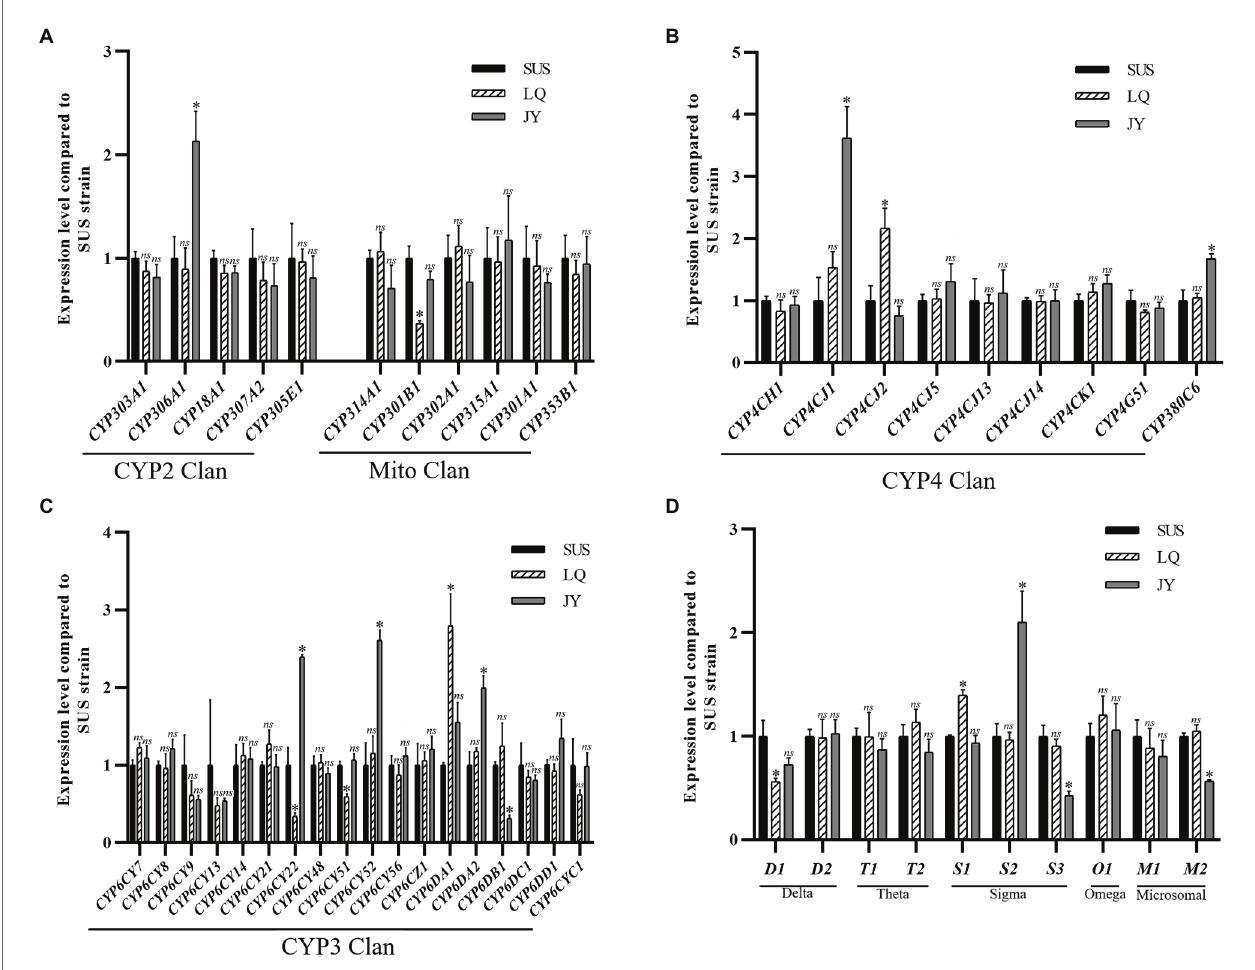
FIGURE 6 | Fold changes of LQ and JY vs. SUS in the expression levels of 10 GST genes the in A. craccivora . The significant differences were marked by asterisks. *Significantly at 0.05 level. The ns represents no significant difference. (A) Fold changes in the expression of P450 genes from CYP2 and Mito Clan. (B) Fold changes in the expression of P450 genes from CYP4 Clan. (C) Fold changes in the expression of P450 genes from CYP3 Clan. (D) Fold changes in the expression of GST